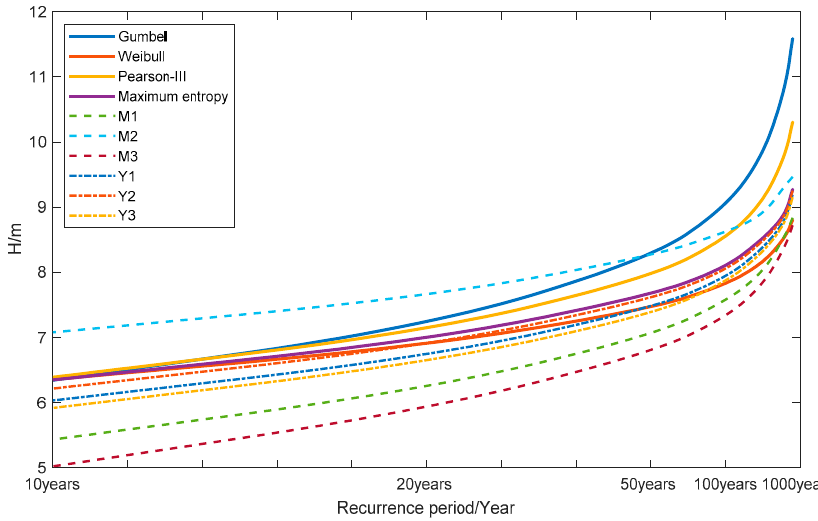
Figure 7. Comparison between the new model and the extreme value distribution.